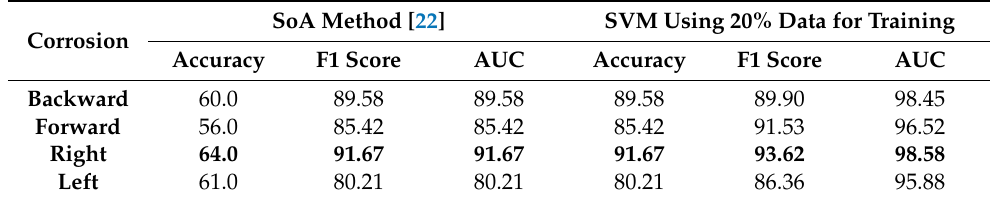
Figure 12. Classification results using 20% data for training at a small volume range (P 2 :15.0 to 25.4 mm 3 ): ( a ) confusion matrix and ( b ) evaluation metrics of accuracy, F1 score, and AUC for each class. Table 3. Evaluation metrics and comparison of the proposed method with the SoA method [22].